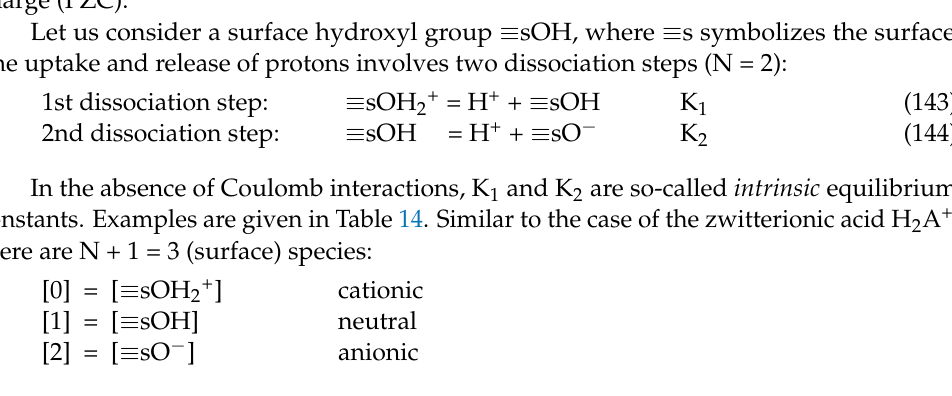
Table 14. Intrinsic pK values and pH pzc for surface complexation on four (clay) minerals [40]. Kaolinite